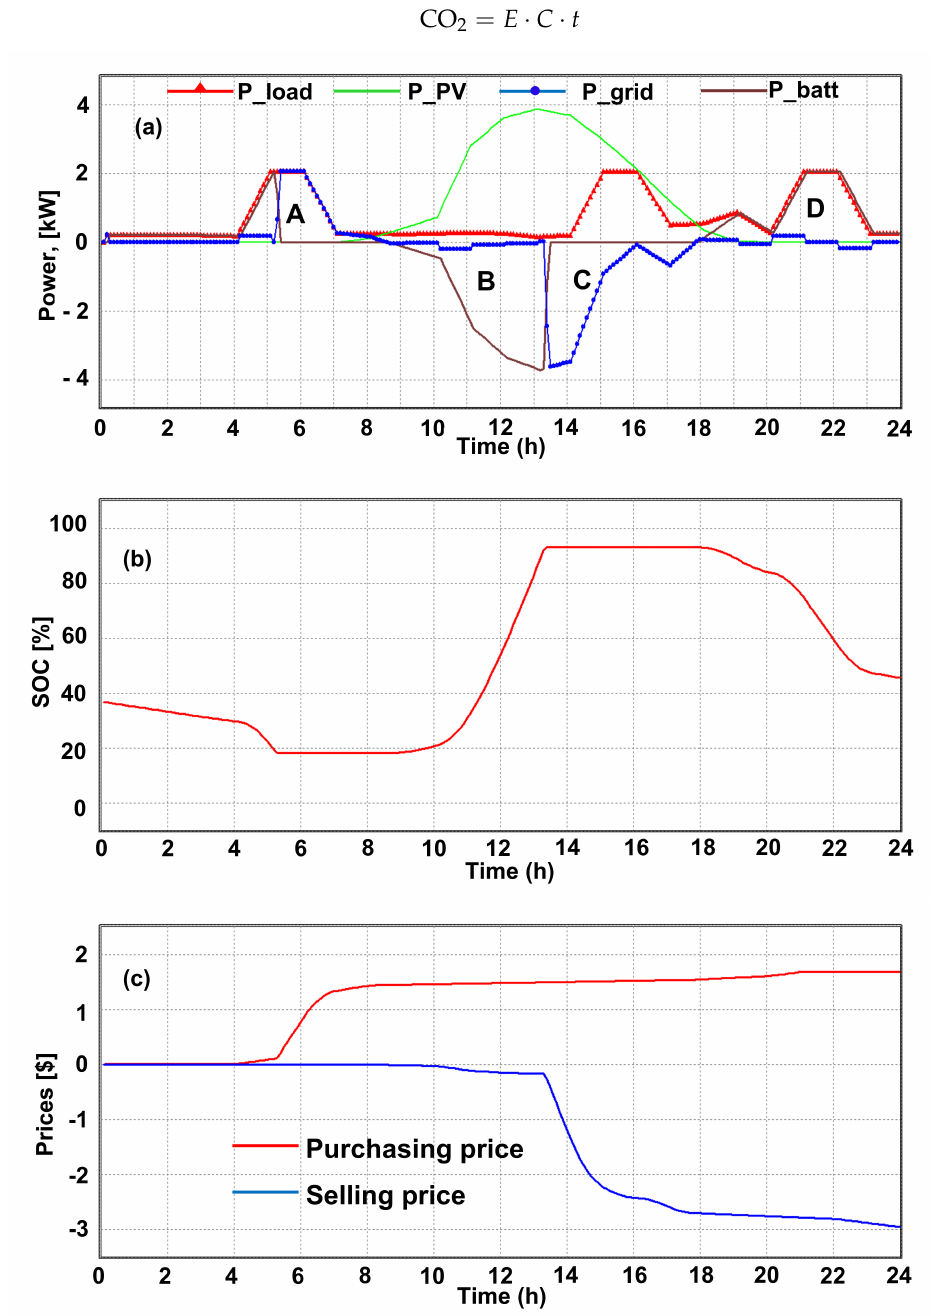
Figure 6. Power flow in a sunny winter: ( a ) PV output power, grid, battery power, and power demand; ( b ) State of charge; ( c )